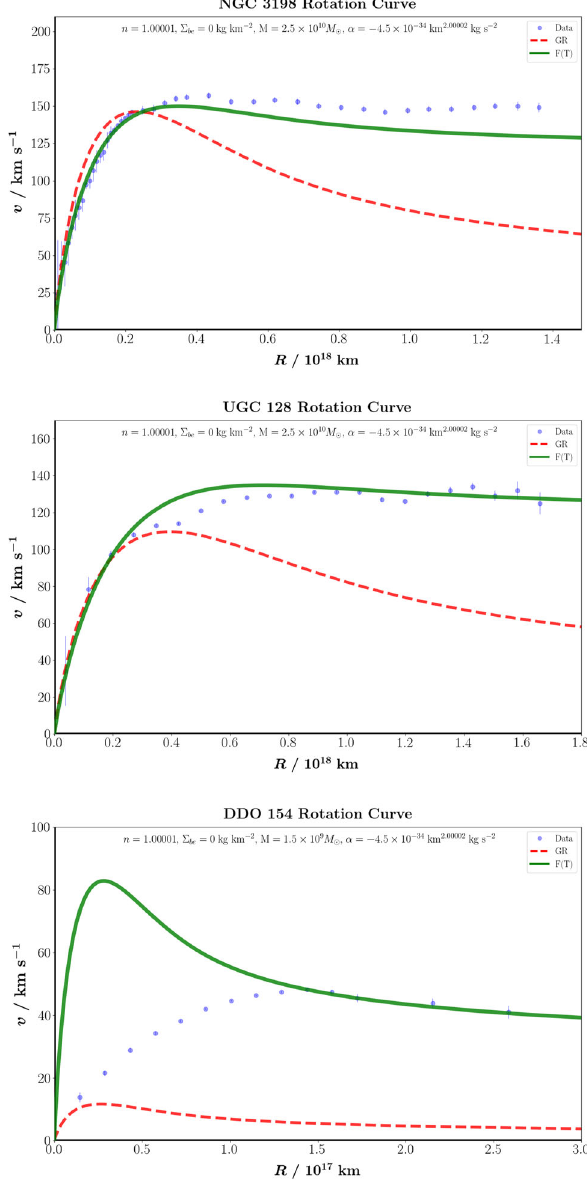
Fig. 6 In these plots the full green curve represents the f ( T ) gravity rotational velocity curves with n = 1 . 00001, with α = − 4 . 51 × − 34 km 2 n kg − 1 s − 2 , and with masses as shown in Table 4. The red dashed curve represent the general relativisticrotation curve and the data points are the rotational velocity data sets provided in Table 5